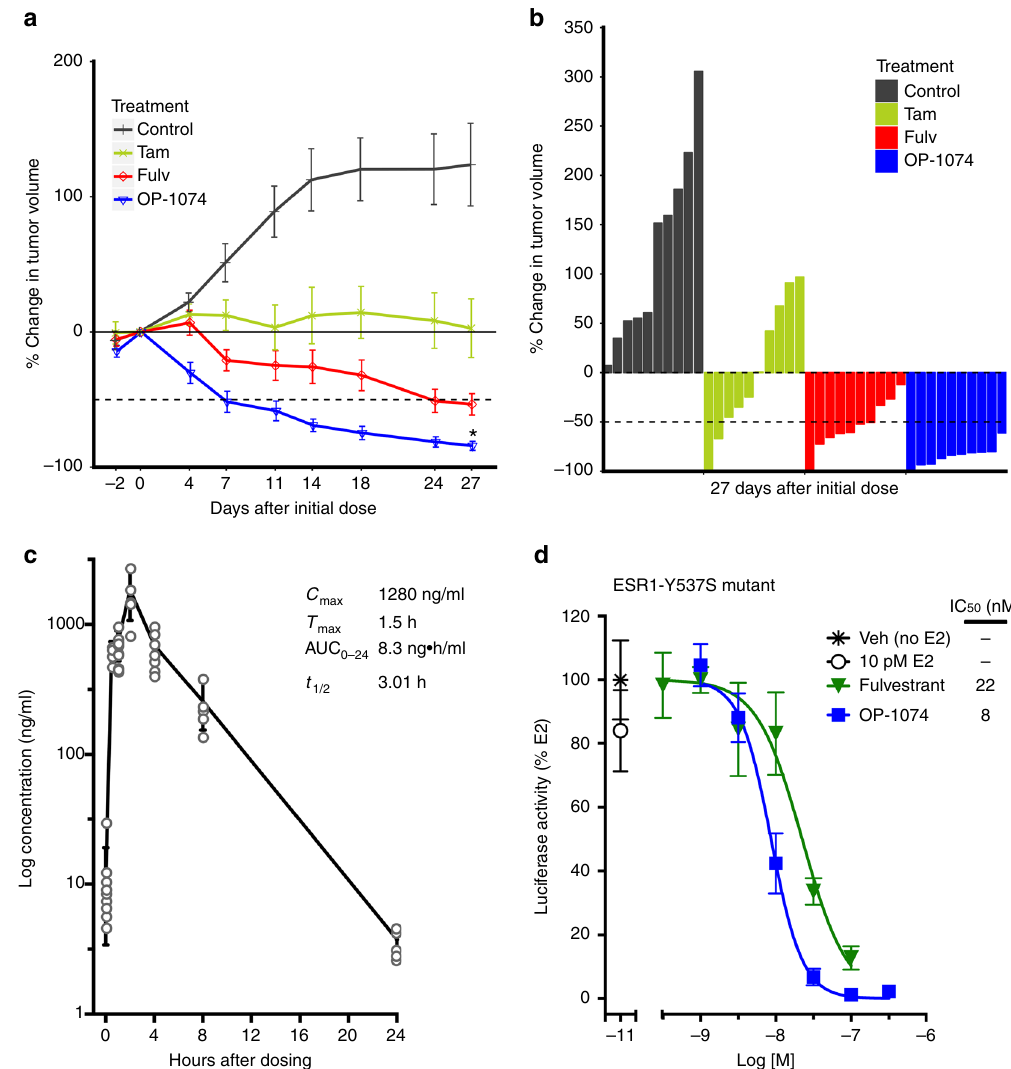
Fig. 7 OP-1074 shrinks tumors in tamoxifen-resistant xenograft model. MCF7/HER2/neu cells were implanted into ovariectomized athymic nude mice implanted with estrogen pellets. Animals were dosed with 100 mg/kg tamoxifen delivered daily by oral gavage, or 100 mg/kg fulvestrant delivered daily subcutaneously, or 100 mg/kg OP-1074 delivered twice daily by oral gavage. a Percent change in tumor volume compared to volume at start of treatment, with each point representing the means±s.e.m., n = 10 animals per group. *Denotes OP-1074 is statistically different from fulvestrant at end of study (student ’ s t -test, p < 0.05). b Waterfall plot of percent fi nal tumor volume at end of the study compared with mean volume at start of treatment, with each bar representing one animal. c Plot of pharmacokinetic data of OP-1074 measured in mouse plasma on the fi nal dose of OP-1074 over a 24-h period. n = 10 animals at time 0, 1, and 4 h. n = 5 animals at time 0.5, 2, 8, and 24 h. d Inhibition of transcription of LBD mutant ER α by OP-1074. Y537S-ESR1 was transiently transfected into SK-BR-3 cells along with an estrogen responsive reporter gene, ERE-tk109-Luc. Luciferase activity was assayed after treating with ligands for 22 h and values were normalized to %vehicle (no E2) control. Shown are means± s.e.m. from triplicate wells of a